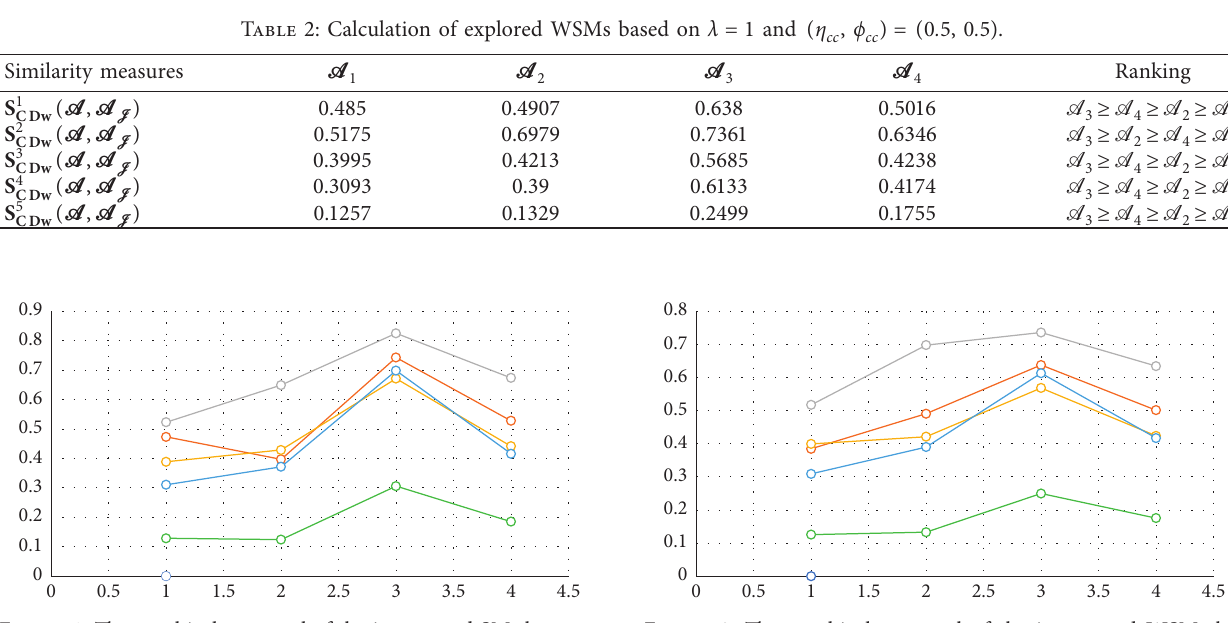
Table 1: Calculation of explored SMs based on λ � 1 and ( η